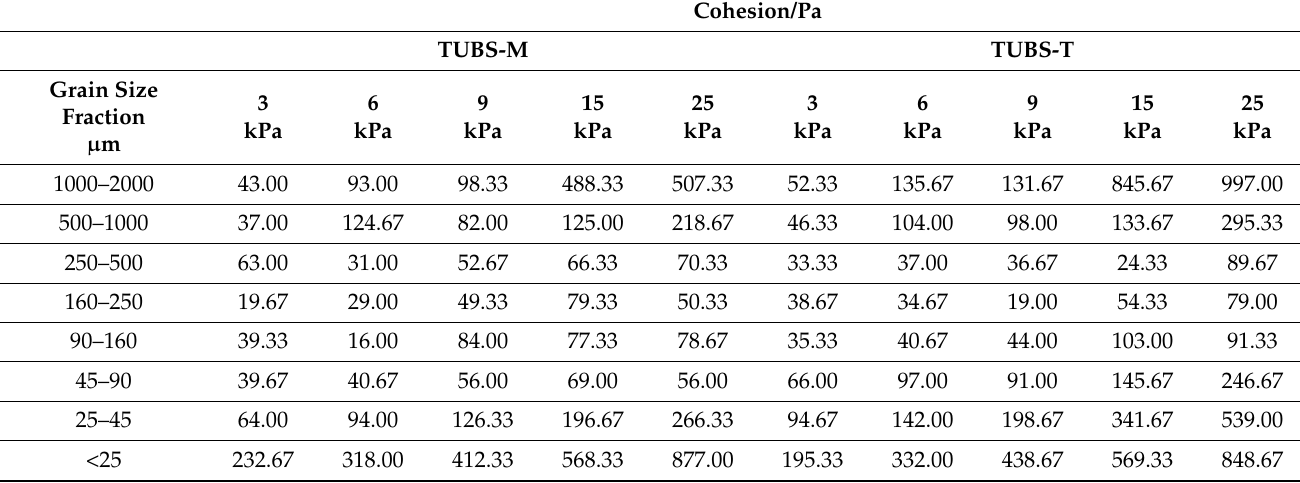
Table A2. Cohesion values of the grain size fractions of TUBS-M and TUBS-T extracted from shear tests at different shear stresses.